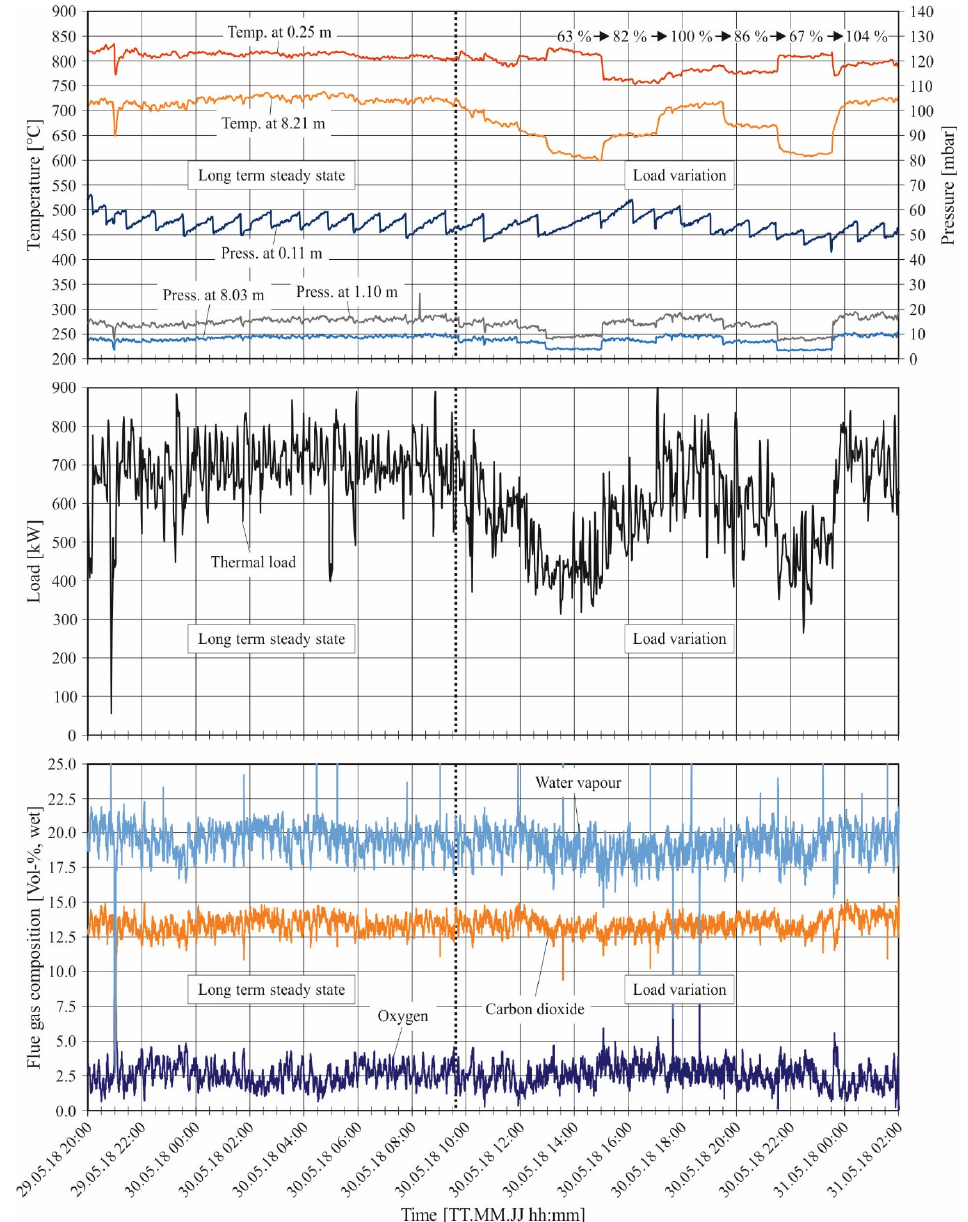
Figure 3. Temperature, pressure, load, and gas composition (co-combustion of lignite and straw).